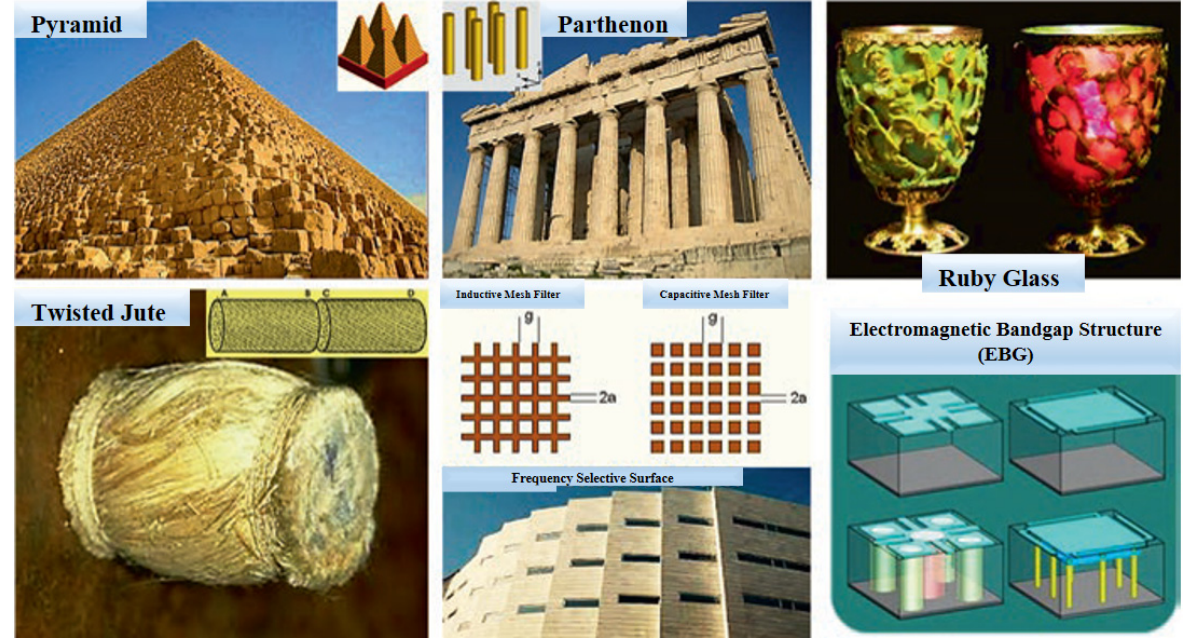
Figure 4. Examples of some “historical” original metamaterials, adapted from Ref. [26]. Metasurfaces